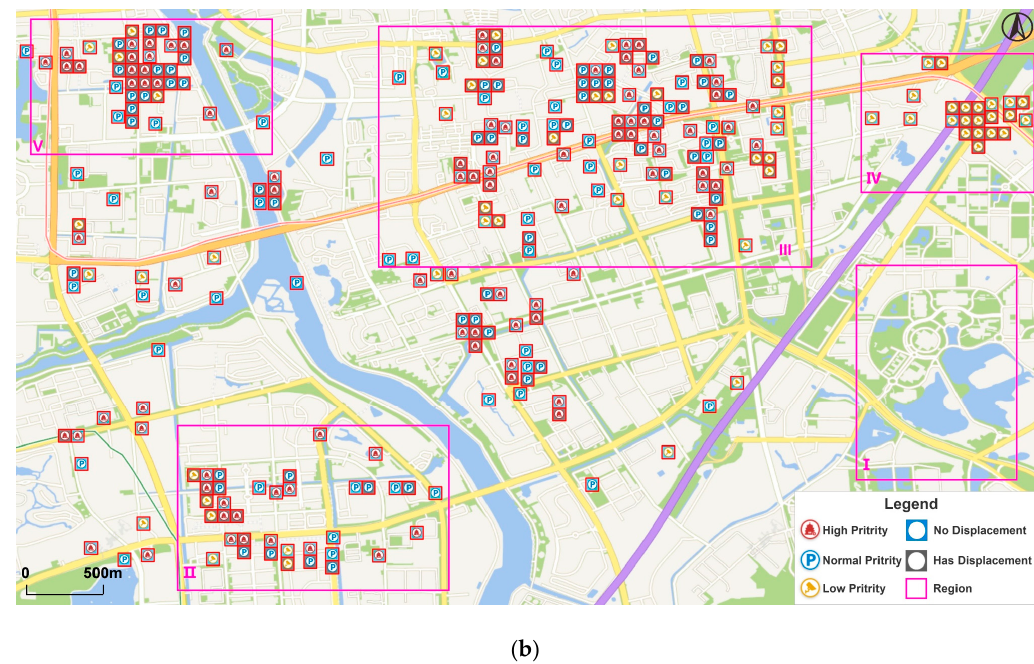
Figure 8. Generalization results of the two methods: ( a ) point data generalized by the proposed method; ( b ) point data generalized by Yang’s method.